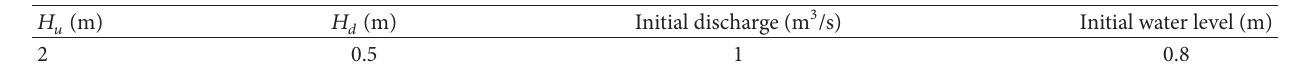
Table 2: Hydraulic conditions of one single-pool canal.